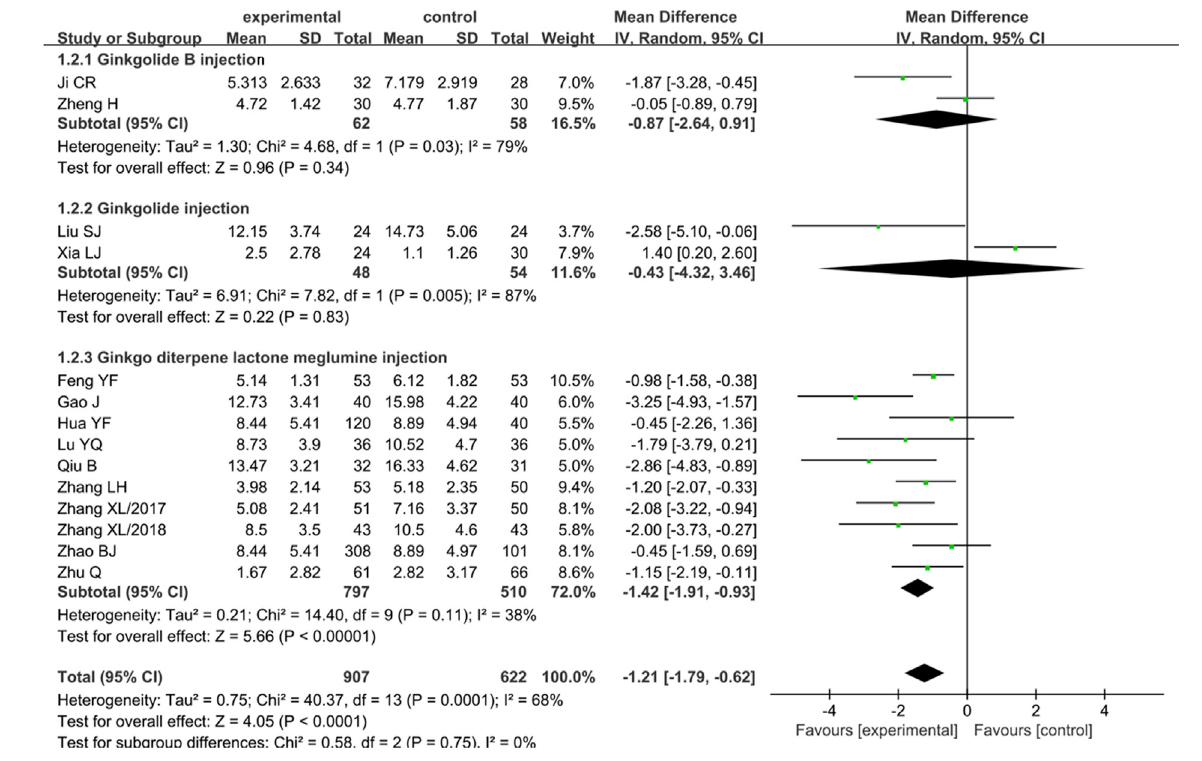
FIGURE 4 | Forest plot of ginkgo terpene lactone preparations on the changes of neurological function de fi cit.